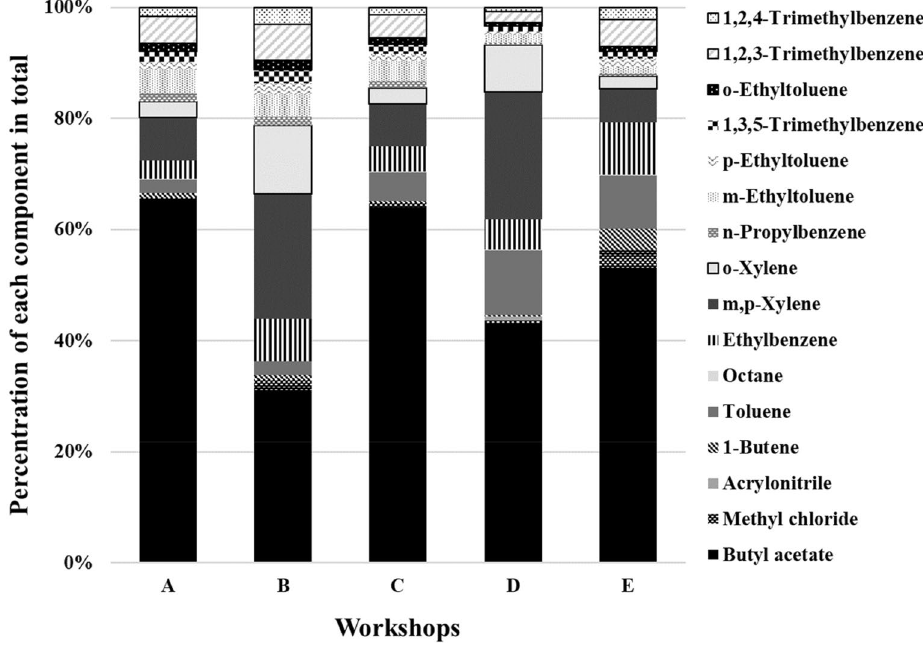
Figure 1. Proportion of volatile organic compound (VOC) species in different workshops during auto-repair painting.